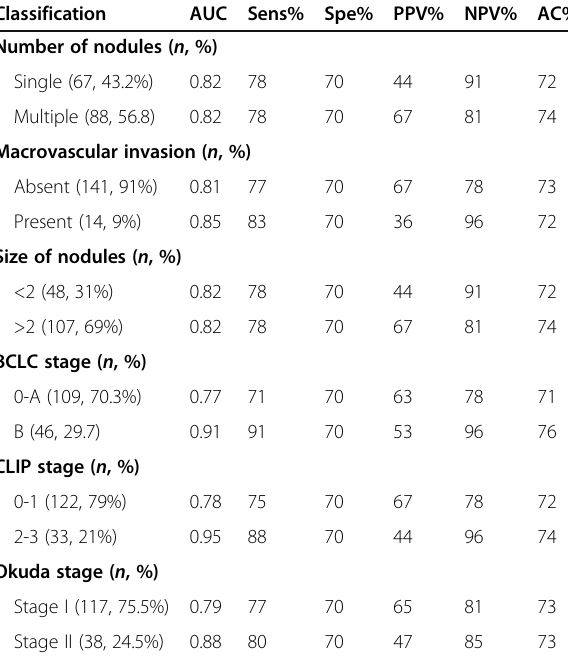
Table 5 Diagnostic power of IL6 to discriminate patients with HCC from patients with cirrhosis in different three staging